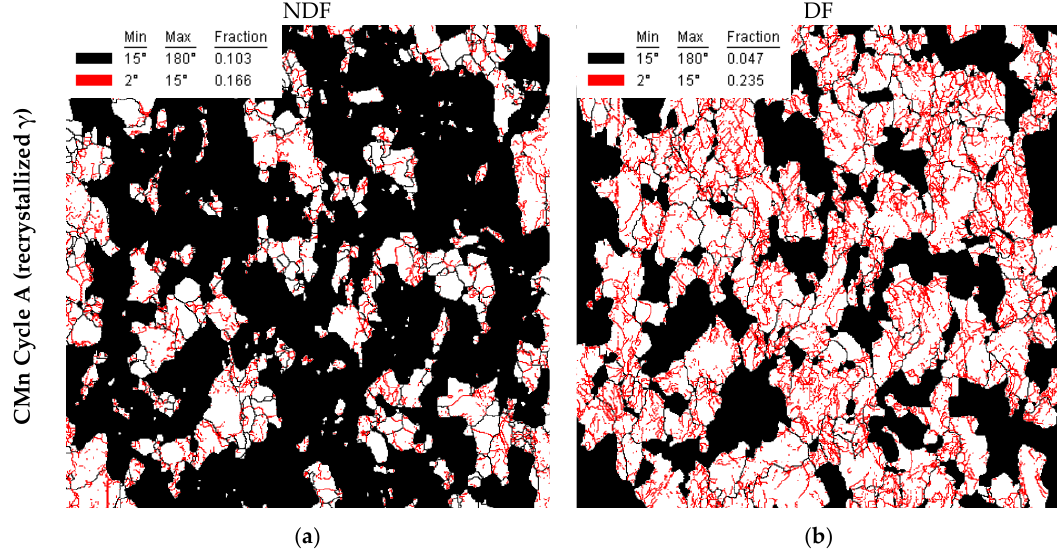
Figure 8. Grain boundary maps (low and high angle boundaries, in red and black color, respectively) corresponding to Tdef50 and CMn steel: ( a ) non-deformed ferrite (NDF) and ( b ) deformed ferrite (DF) family.